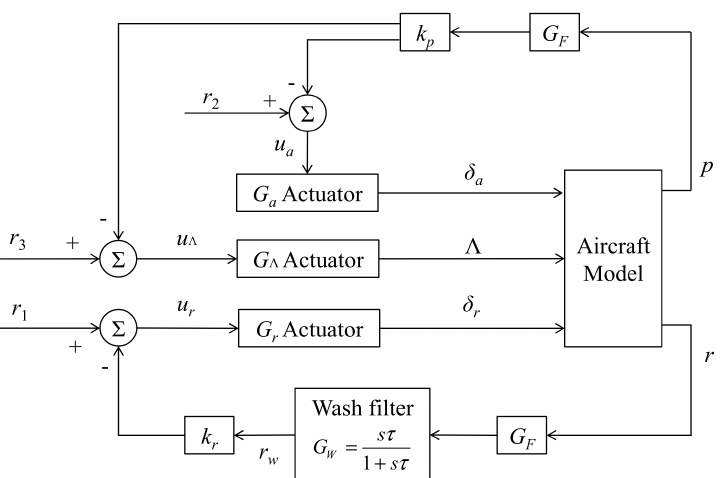
Figure 2. Lateral/directional augmentation system. The body-axis roll rate is fed back to the ailerons and sweep angle to modify the roll subsidence modal, and yaw rate is fed back to the rudder on the V-tail to modify the Dutch roll